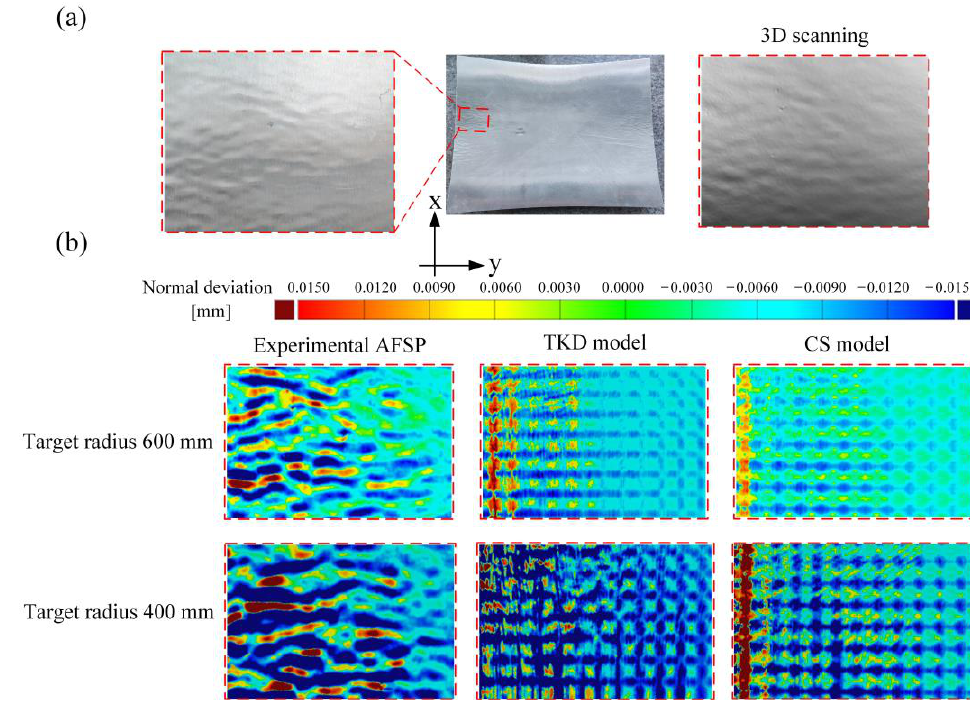
Figure 9. ( a ) Illumination map and 3D scanning diagram of spherical AFSP upper face sheet. ( b ) Normal deviation of spherical AFSP surface under different target radii.